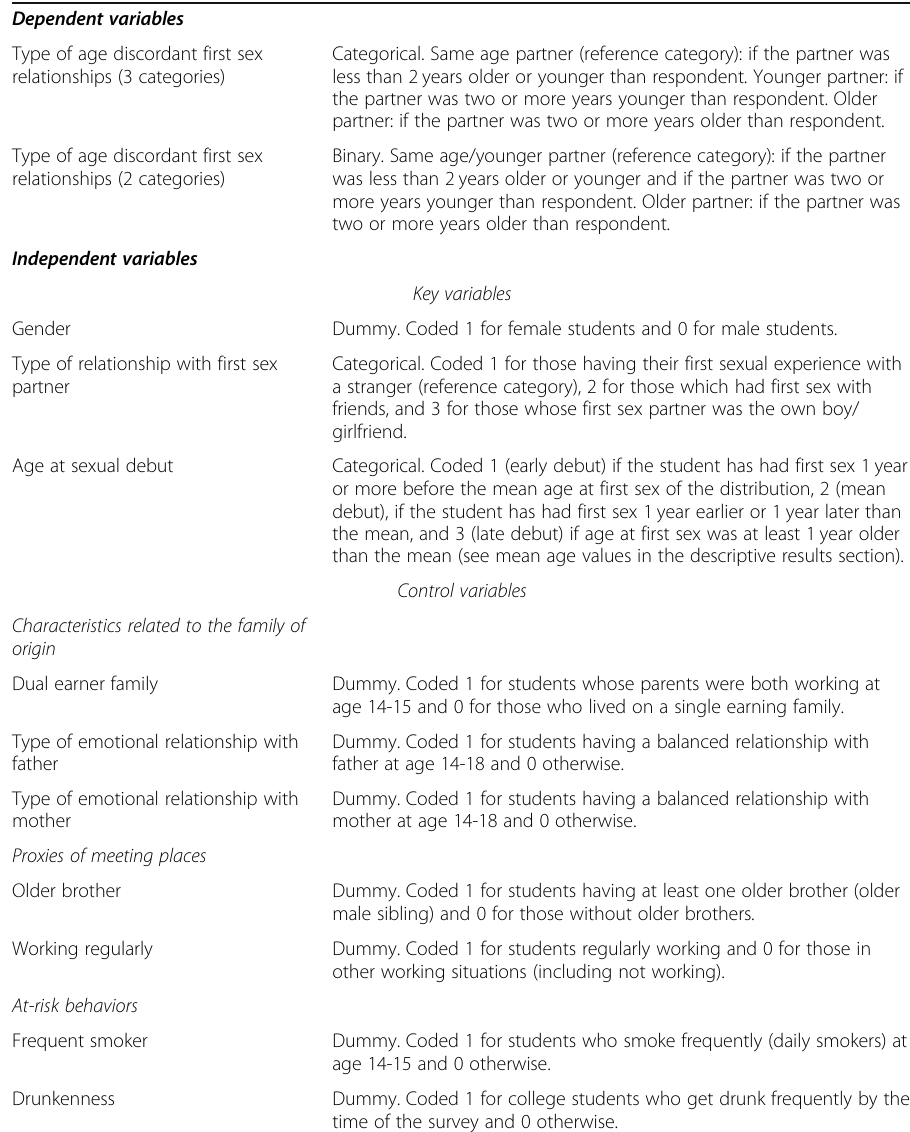
Table 1 Dependent variables and covariates included in multinomial and binary logistic regression models